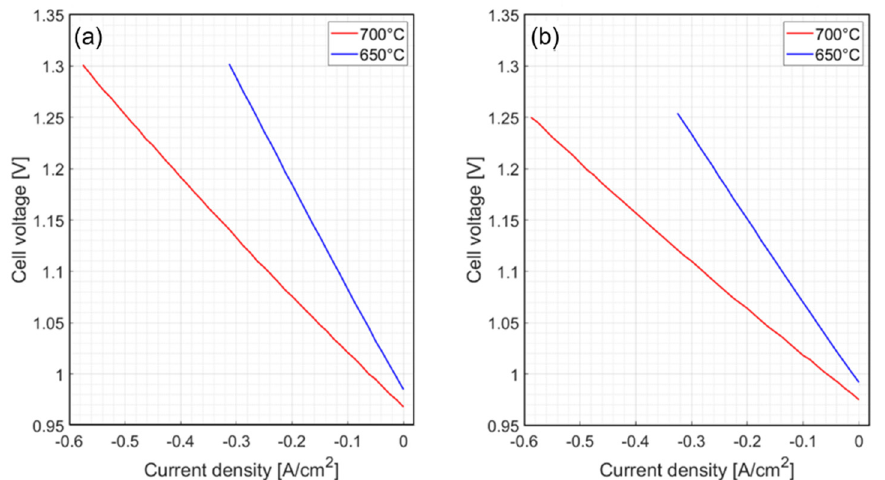
Figure 2. iV curves in electrolysis mode of ( a ) the ceramic fuel electrode supported cell with a Ni/YSZ fuel electrode and ( b ) the metal supported cell with a Ni/GDC-LSFNT fuel electrode. 650 °C (blue curves) and 700 °C (red curves) using 50% H 2 O/H 2 vs. air. The measured open circuit voltages (OCV) were in the range of the expected values according to the Nernst equation, with minor deviations of only ca. 2–6 mV, verifying a tight setup. The ASR of the ceramic SoA cell calculated from the slope of the iV-curve at − 0.25 A/cm 2 were 1.03 and 0.52 Ω ·cm 2 at 650 and 700 °C, respectively, and 0.83 and 0.48 Ω ·cm 2 at 650 and 700 °C, respectively, for the metal supported cell.